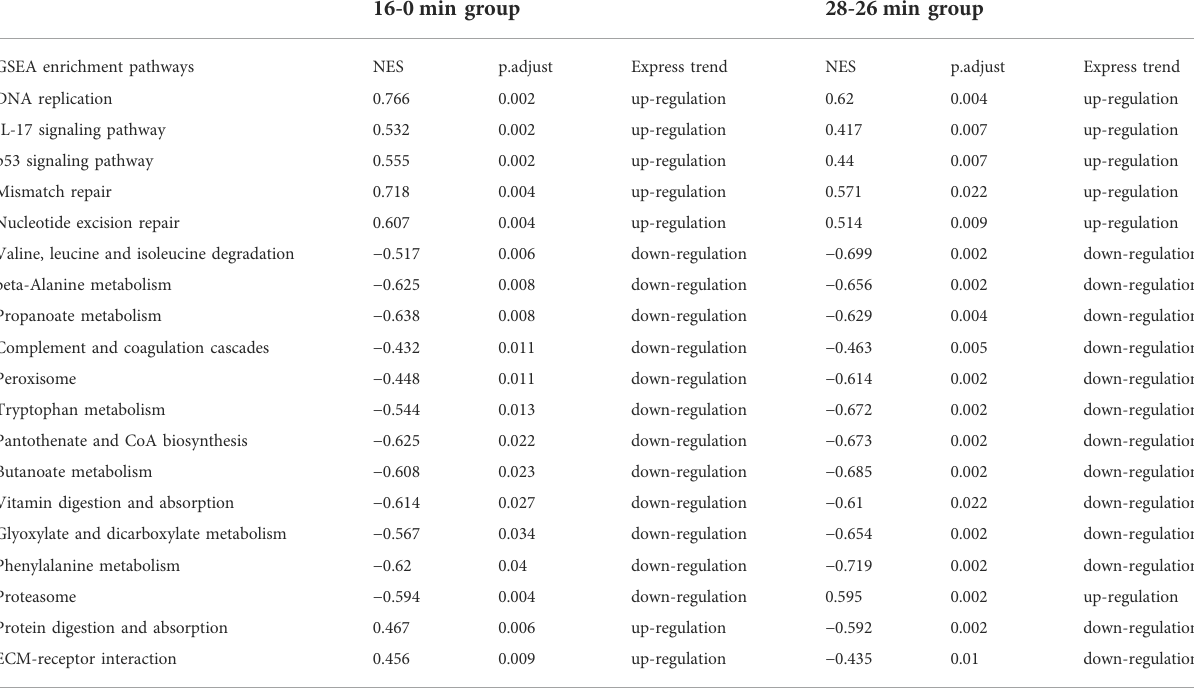
TABLE 1 The common enrichment pathways in GSEA analysis of genes in 16min – 0min group and 28min – 26min